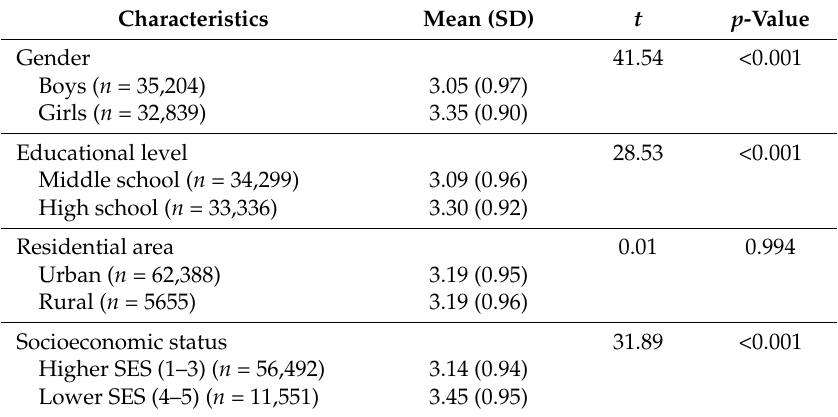
Table 1. Differences in stress levels among Korean adolescents according to individual